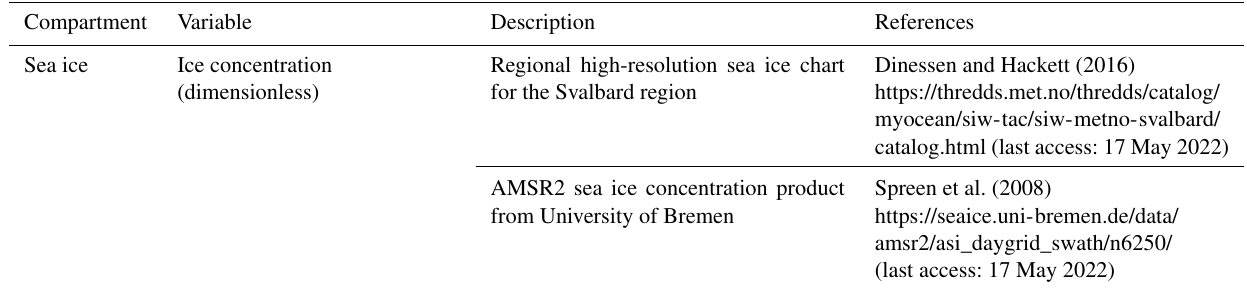
Table 3. Datasets used for Barents-2.5km model evaluation. The listed references include links to the repositories where data and details on sampling and data processing can be found.